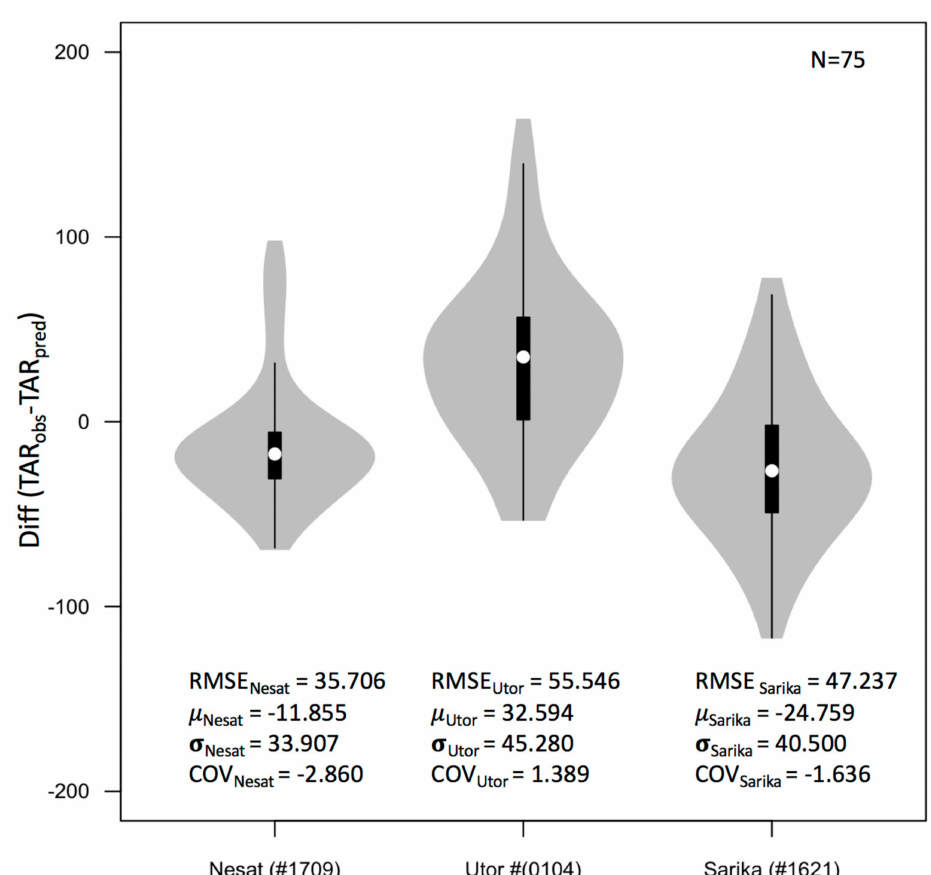
Figure 8. Violin plots (boxplot-density trace synergism) of the TAR di ff erence between the observed and predicted values for 75 stations along the southern and southeastern coasts of China for typhoons Nesat (#1709), Utor (#0104), and Sarika (#1621). The white circles indicate the median value of the TAR di ff erence for 75